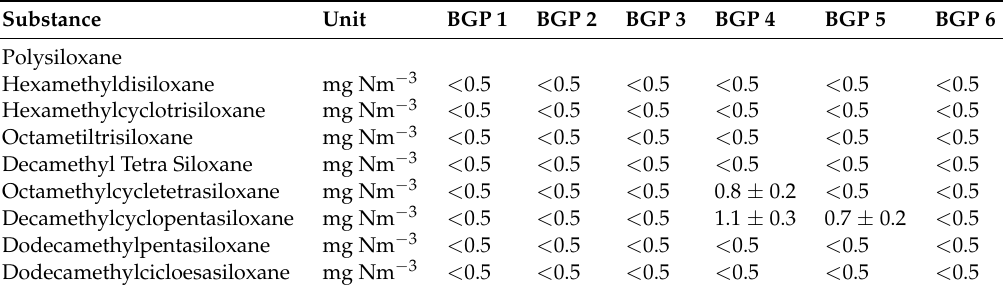
Table 9. Biogas composition—part 2.